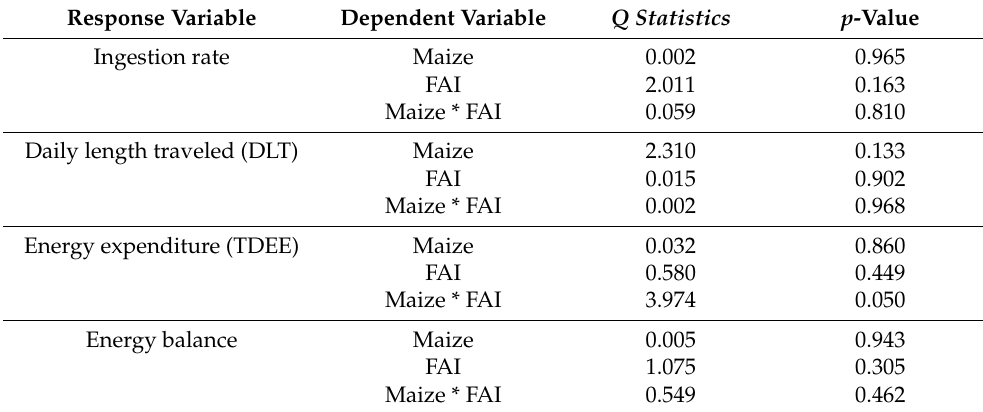
Table 4. Results of the robust two-way ANOVA for ingestion rate, daily paths, energy expenditures, and energy balance.